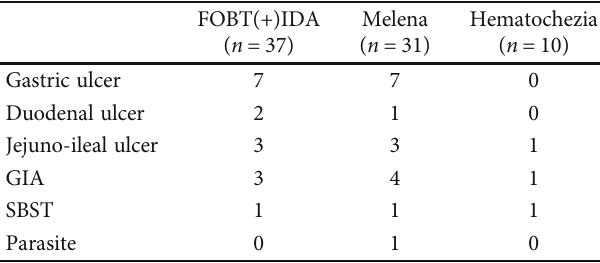
Figure 3: A case of SMT identi fi ed by MCCG (a) and con fi rmed with EUS (b). Table 3: Results of MCCG for nonhematemesis GI